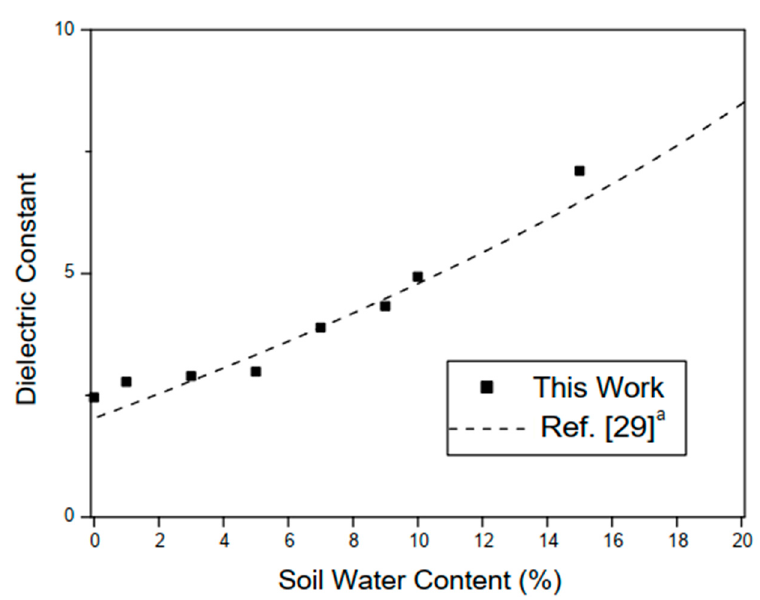
Figure 10. Measured results for different SWC (%) with red clay. a Soil obtained in the region of Yingtan, Jiangxi Province of China.